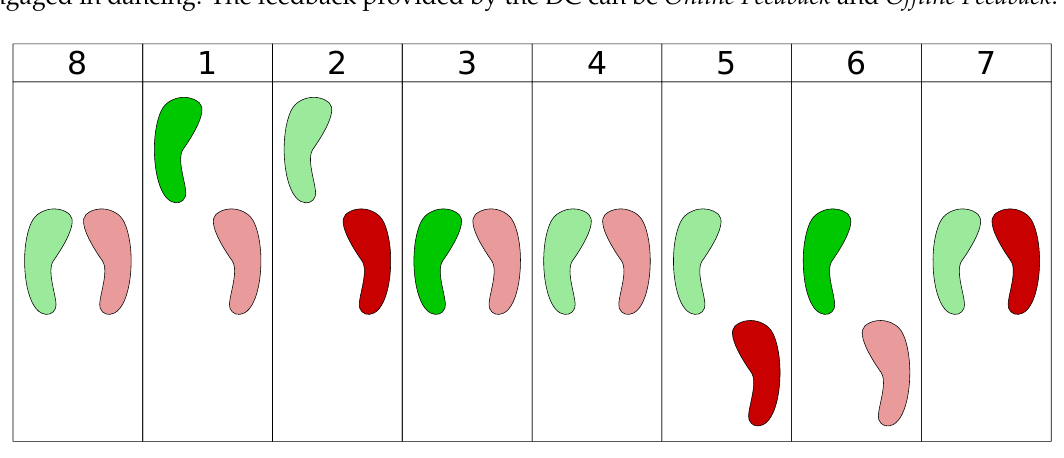
Figure 1. User Interface (UI) guide for the basic forth and back salsa dancing steps. The solid color indicates the foot that needs to be moved.